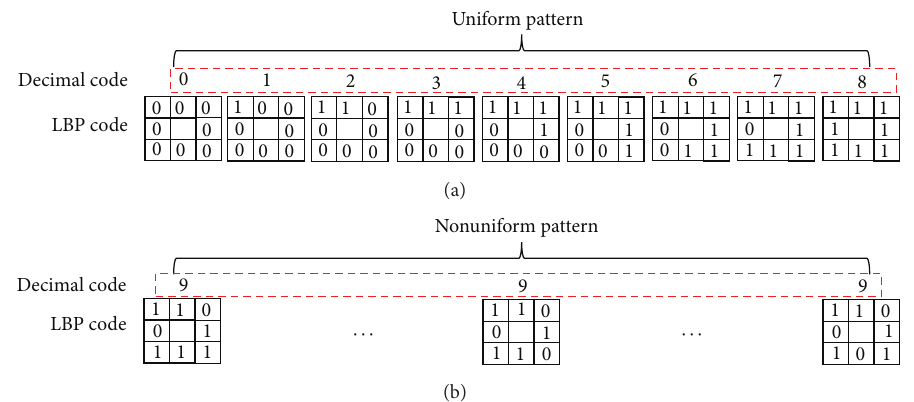
Figure 6: Example of uniform and nonuniform patterns and their assigned decimal codes in the case in which 𝑅 and 𝑃 are one and eight, respectively: (a) uniform patterns and (b) nonuniform